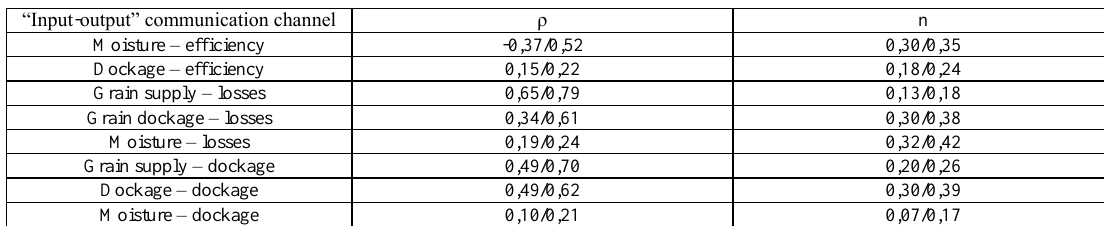
Table 3. The correlation coefficients and the degree of nonlinearity between the input and output processes of one-dimensional